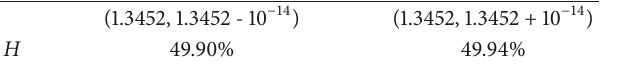
Table 5: The difference between generated binary sequences with different 𝑥 0 .